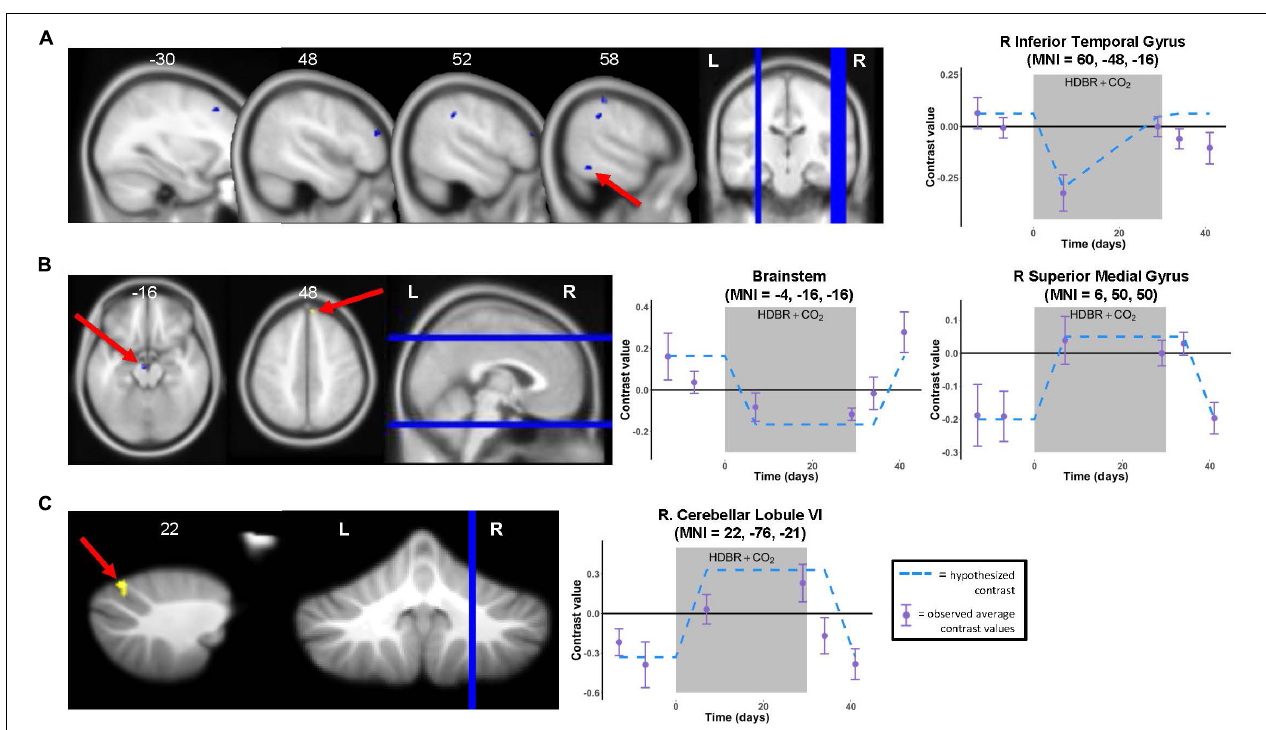
FIGURE 4 | Time course of neural vestibular response to HDBR + CO 2 . Left panels: Regions showing whole brain (A,B) and cerebellar (C) longitudinal changes in activation during vestibular stimulation across the six time points. Whole brain and cerebellar results are overlaid onto MNI and SUIT standard templates, respectively; p < 0.001, k = 10 for whole brain analyses; k = 5 for cerebellar analyses. Three clusters survived p < 0.0005, k = 10 correction (see Table 2 ). Right panels: Example contrast values plotted for peak coordinate within the cluster with the largest T value in each case (cluster indicated by red arrow). Points represent group mean contrast values; error bars represent standard error. Dotted lines depict the hypothesized longitudinal contrasts for “instant decrease, during-HDBR + CO 2 recovery” (A) , “instant decrease, post-HDBR + CO 2 recovery” (B) , and “instant increase, post-HDBR + CO 2 recovery” (B,C)